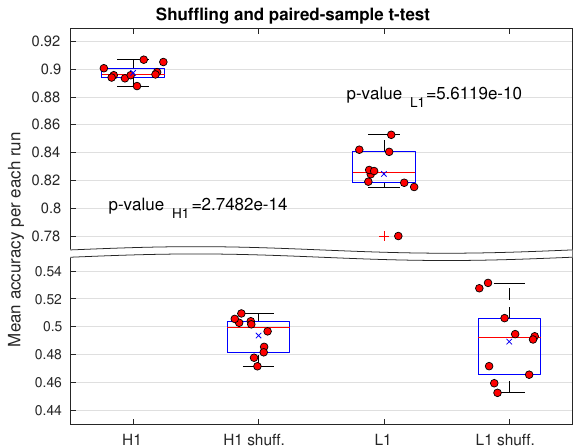
Figure 12. Shuffling and paired-sample t-test for elucidating if predictions of our CNN are statistically significant. Boxplots for the mean accuracies resulting of each experiment of the 10-fold CV, are shown. By shuffling, we mean that our training set is shuffled before each training, such that links between each sample and its known class is broken. Besides, the p-values of the mentioned paired- sample t-test are included, showing that predictions of the CNN are significantly different from a totally random process—with a significance level of